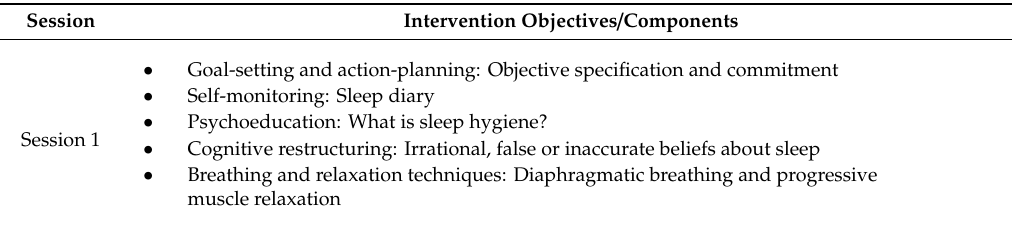
Table 5. Summary of components of the sleep hygiene module per